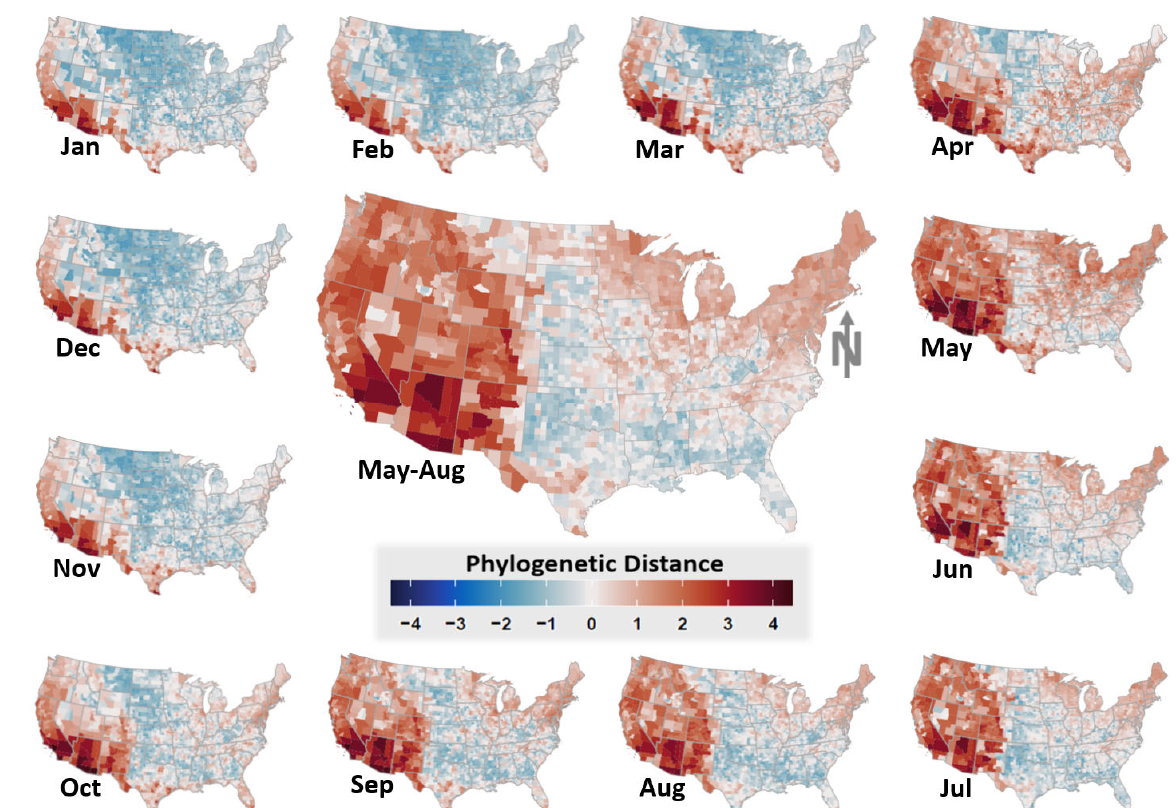
Figure 4. Dynamic and static avian phylogenetic distance. Phylogenetic distance covariate under assumption of dynamic (monthly) and static (seasonal) species pools. Dynamic version is shown as a monthly varying time-series surrounding the larger map at center, which represents static phylogenetic distance (May–August). Mapped values have been scaled and centered to highlight locations subject to relative phylogenetic clustering with blue colors (higher than expected relatedness, lower mean genetic distances) and phylogenetic over-dispersion with red colors (lower than expected relatedness, higher mean genetic